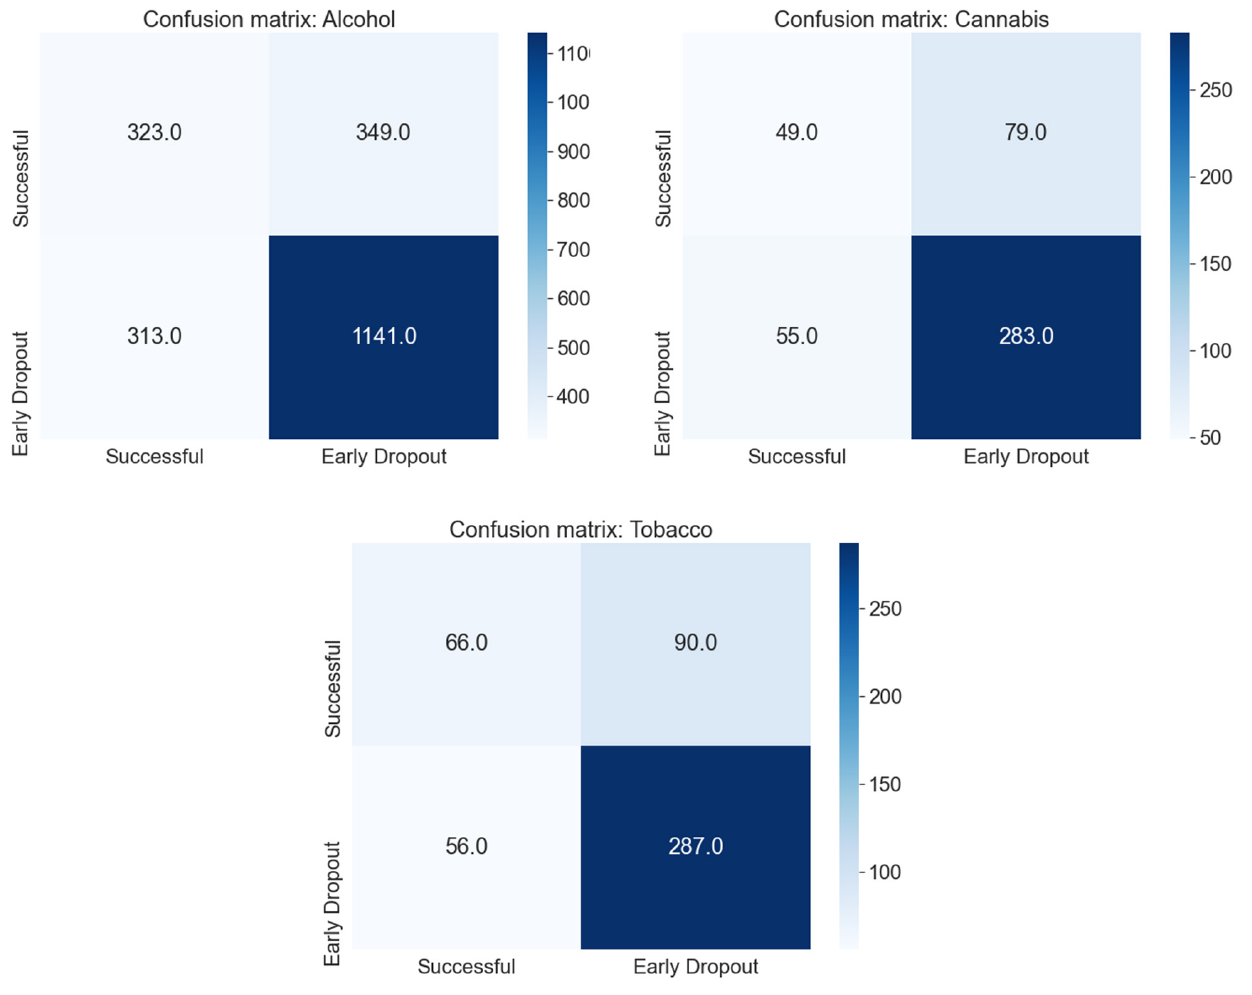
FIGURE 2 | Confusion matrix for all cross-validation iterations for each substance using the Random Forest model and the standard definition of early dropout and success (reaching module 6 and 7 days of the target